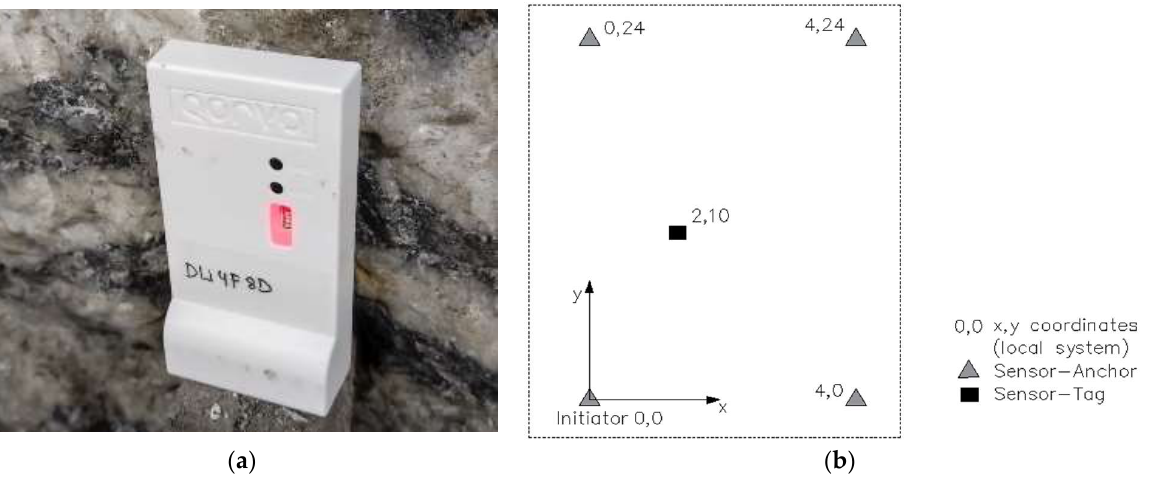
Figure 1. ( a ) QORVO sensor tag attached to the drift wall; and ( b ) position of the anchors and moving target.